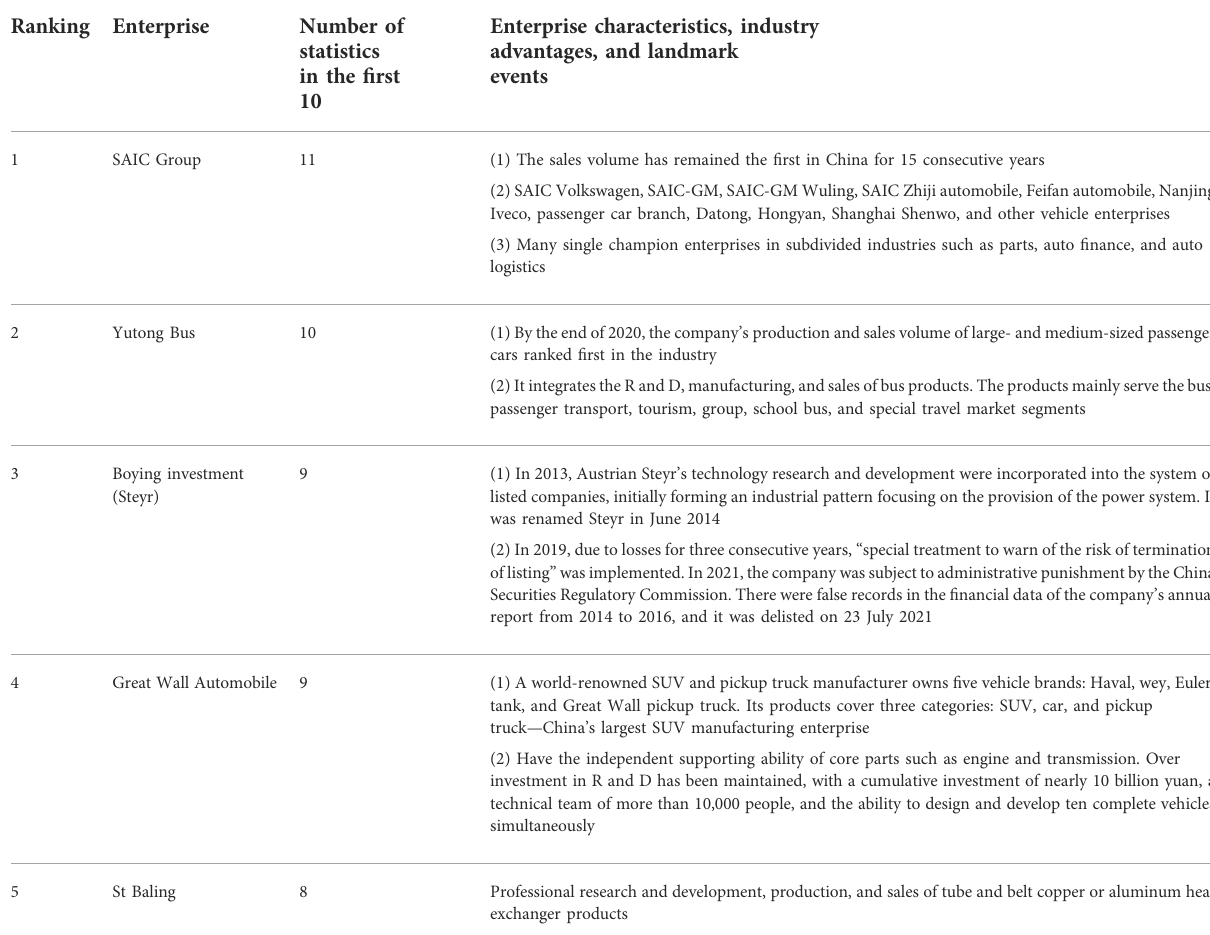
TABLE 3 Top 10 quarterly statistics of China ’ s auto fi nance market network from 2012 to 2020.